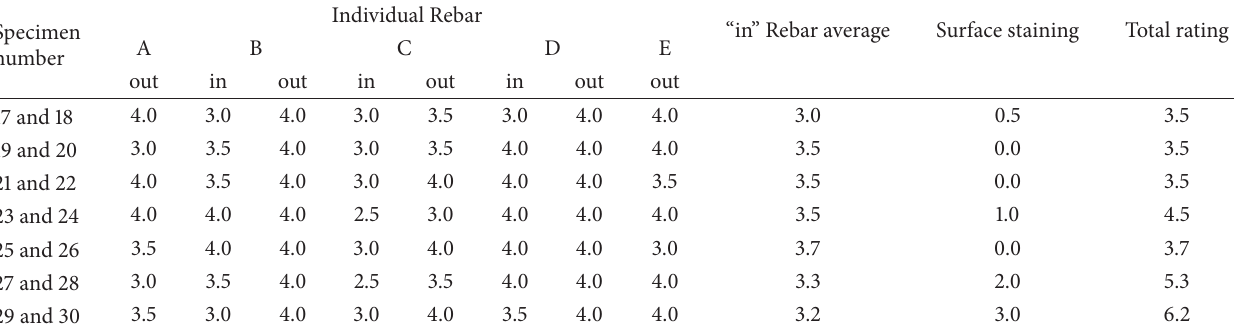
Table 7: Rating of concrete staining and reinforcing steel for CoC specimens after 6 months. Specimen